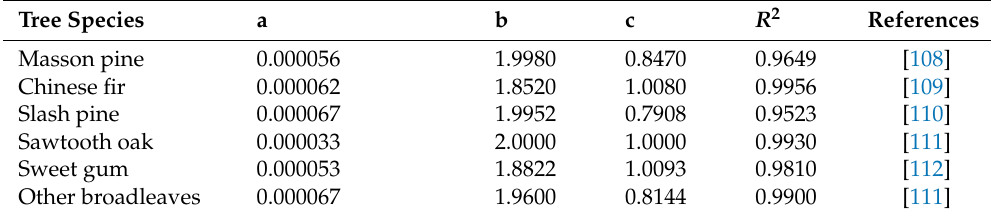
Table A2. Equations used in this study for volume